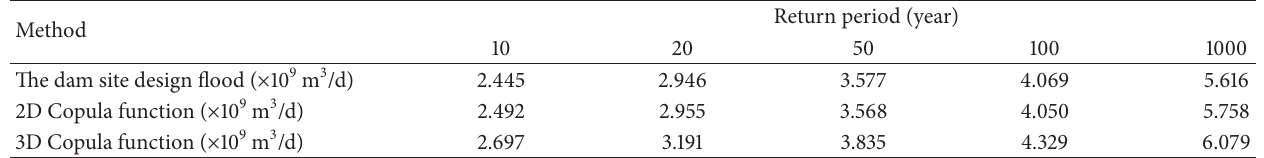
Table 6: The design flood calculated by different methods under a range of return periods.